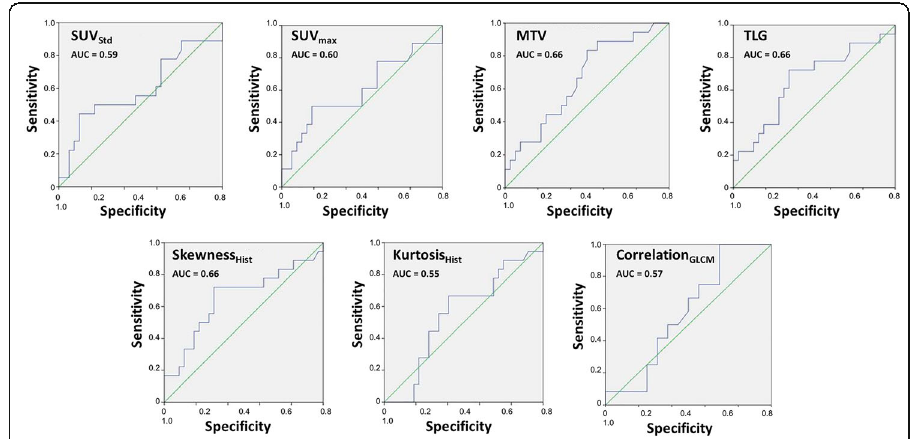
Fig. 4 The ROC curves (together with the reference 50% AUC line) for the conventional parameters (upper panel) and the texture related features (bottom